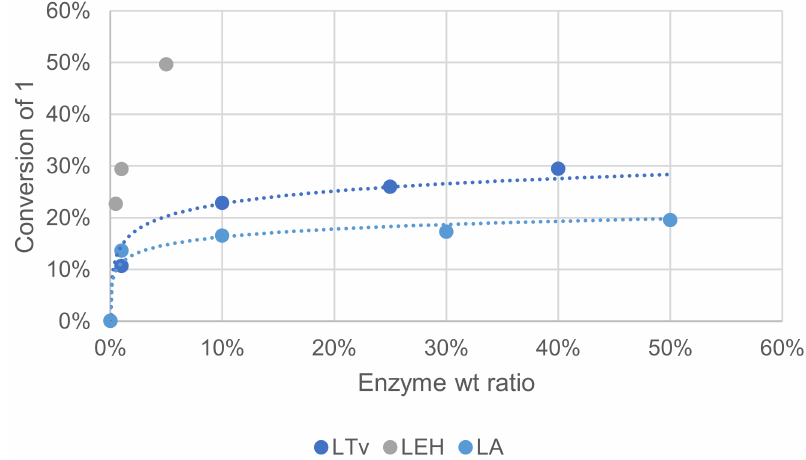
Figure 7. Effect of the enzyme source on the conversion of 1 in the laccase-catalyzed oxidation (laccase 1—50% w/w , HOBt 10 mol%, acetate buffer pH5 0.25 M, O 2 atmosphere, incubation for 24 h, 40 ◦ C, 200 rpm).